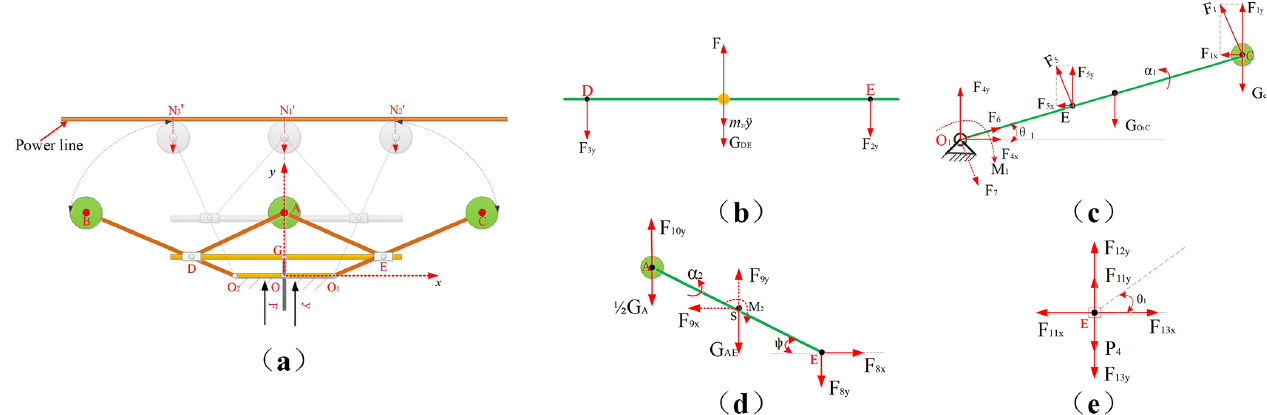
Figure 10. Schematic diagram of the pressing component. (a) Dynamics model of the pressing component. (b–e) Force analysis of rods.